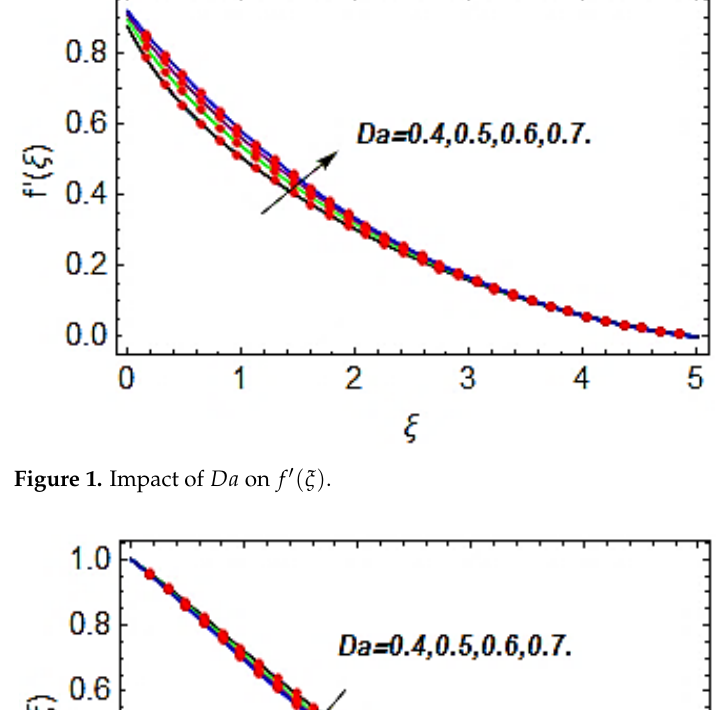
Figure 1. Impact of Da on f (cid:48) ( ξ ) .